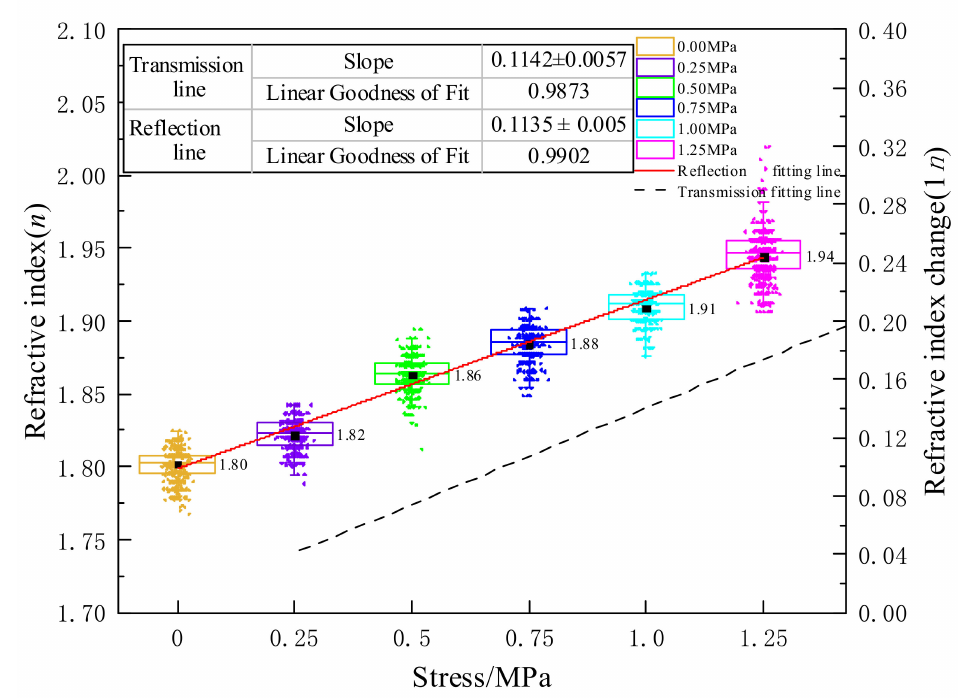
Figure 12. Relation between the refractive index and